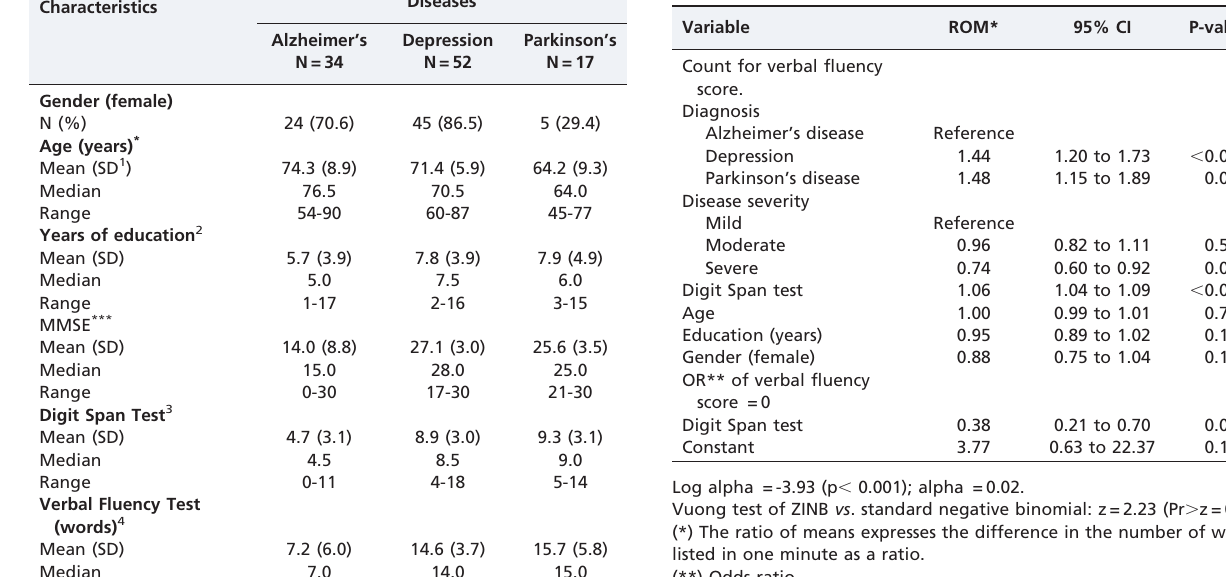
Table 3 - Zero-inflated negative binomial regression of verbal fluency scores according to demographic and clinical variables. Variable ROM* 95% CI P-value Count for verbal fluency